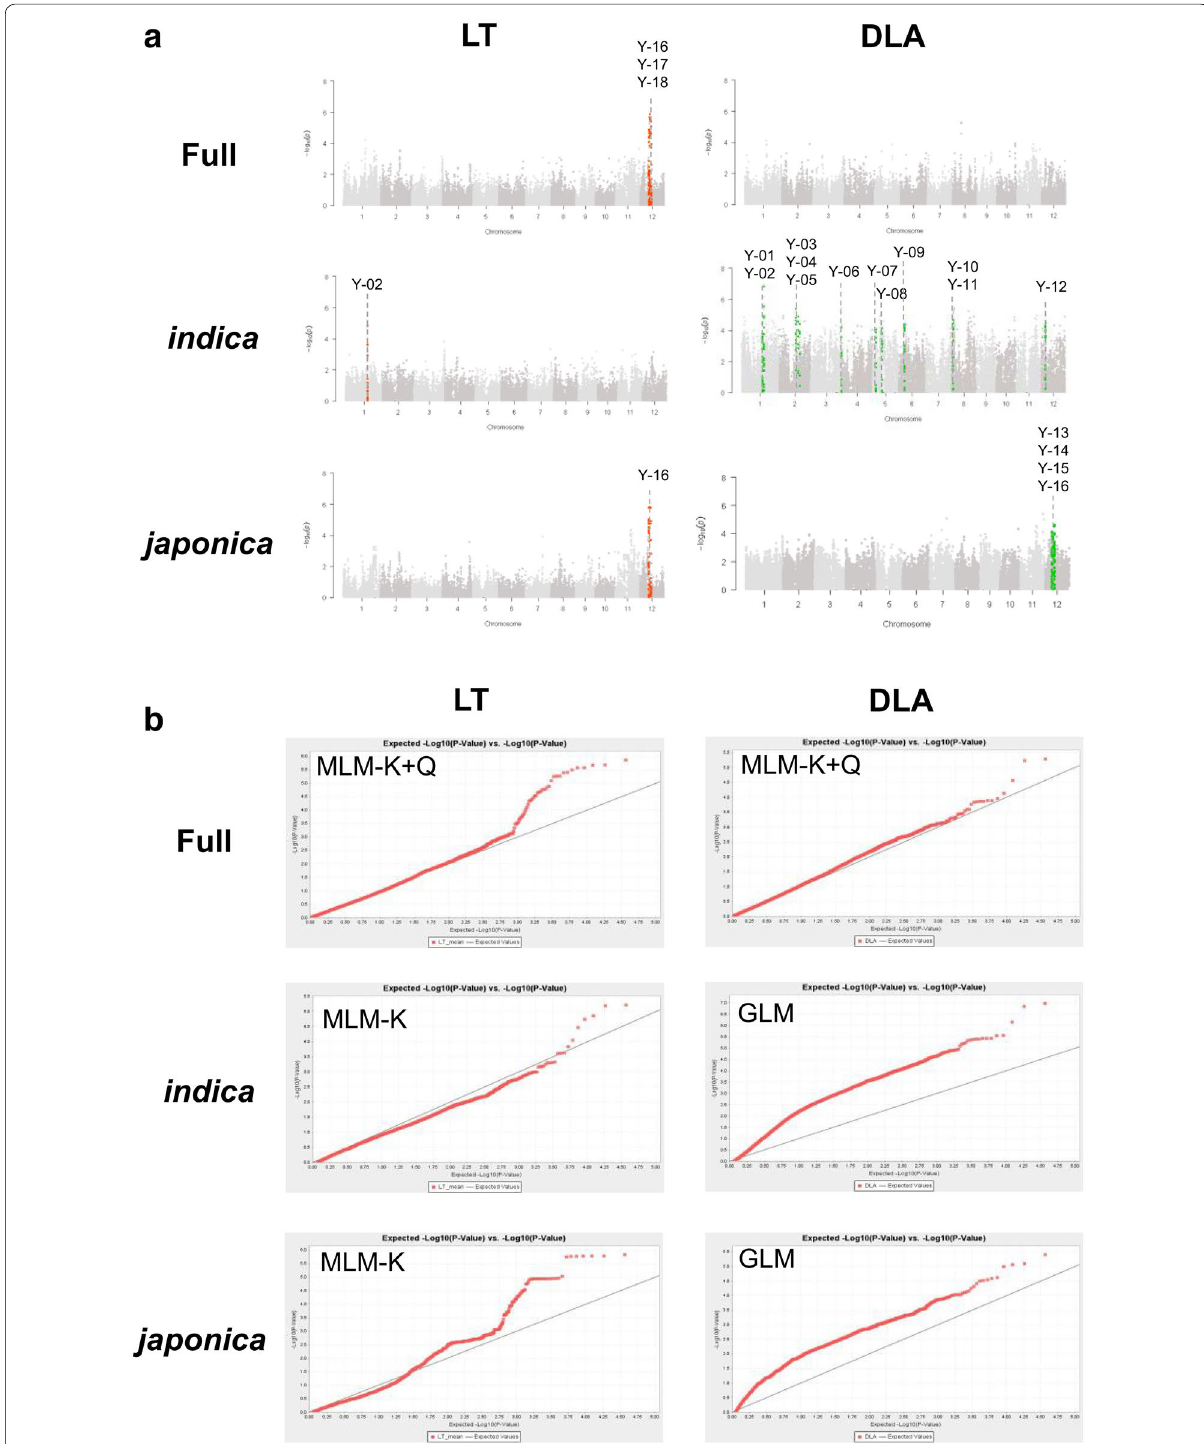
Fig. 3 GWAS of loci associated with resistance to M. oryzae isolate 12YL‑DL‑3‑2. a Manhattan plots show significant genomic regions (Y‑01 to Y‑18) identified by using lesion type (LT) and diseased leaf area (DLA) datasets. X axis: rice chromosomes; Y axis: (Q–Q) plots show the fitness of the selected models used for different traits in the full population or subgroups. X axis: expected observed Log 10 ( P −